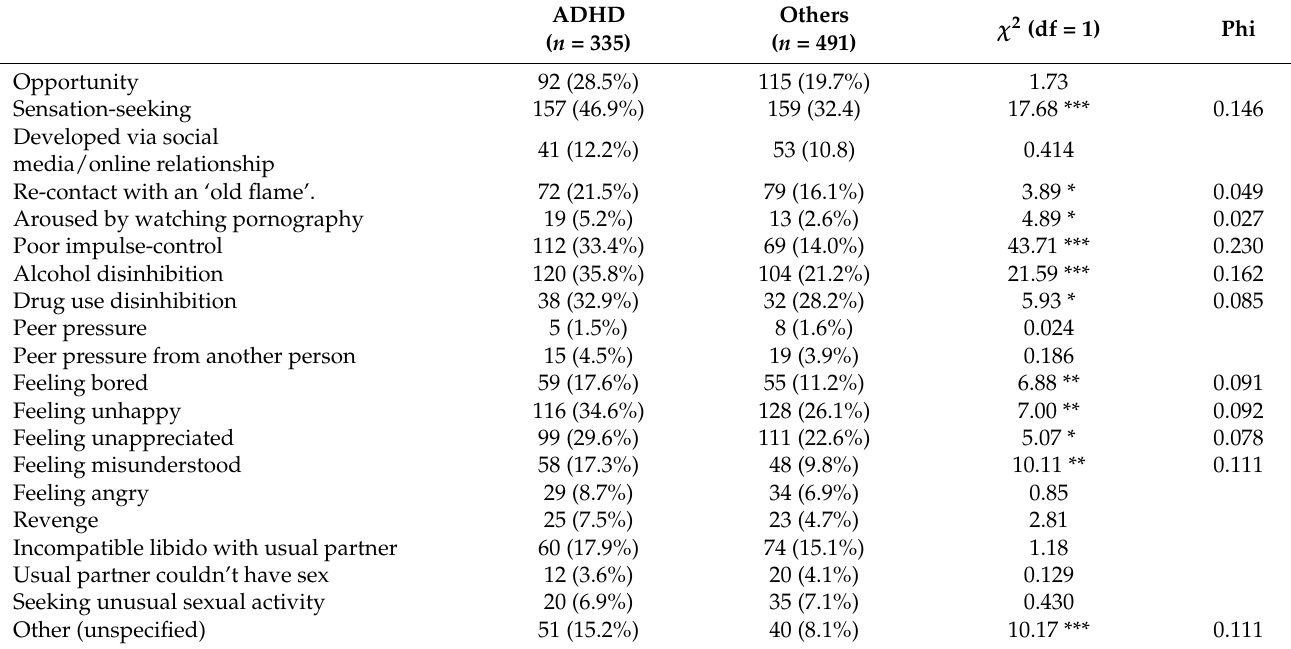
Table 7. Differences between ADHD and other participants in the motivation behind extra-partner affairs from a pre-determined list ( n =